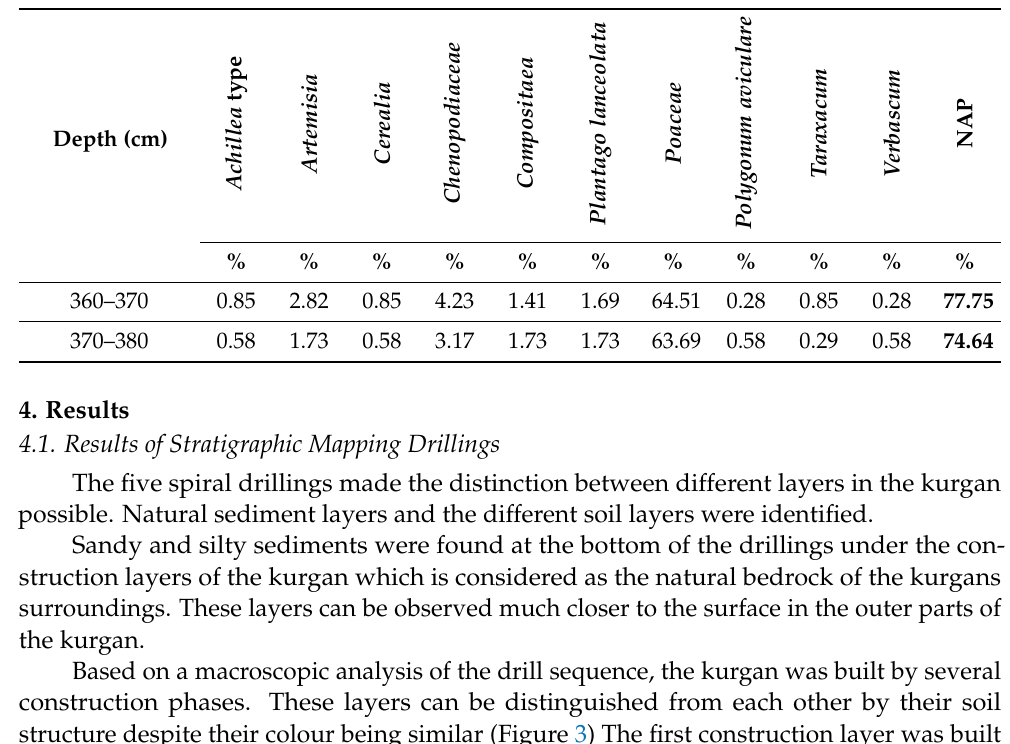
Table 2. Pollen composition and proportion of non-arboreal pollen (NAP) material extracted from the samples of Cs á sz á rn é